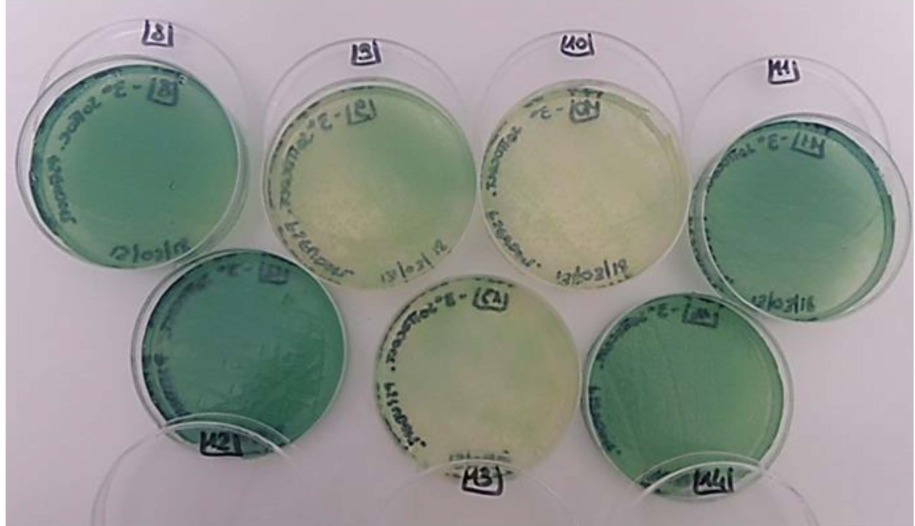
Figure 2. Representative visual observations of the positive cultures in cetrimide agar of P. aeru- ginosa ATCC 9027 from each inoculated resin.